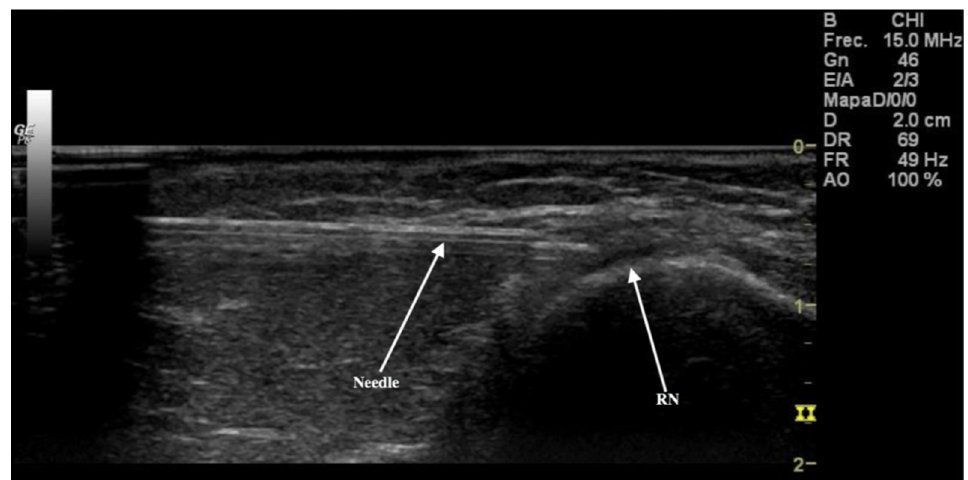
Figure 3. Ultrasound image of the radial nerve (RN) (white arrow) that is in contact with the humerus bone. Needle injected dye in the nerve point before crossing the lateral intermuscular septum.